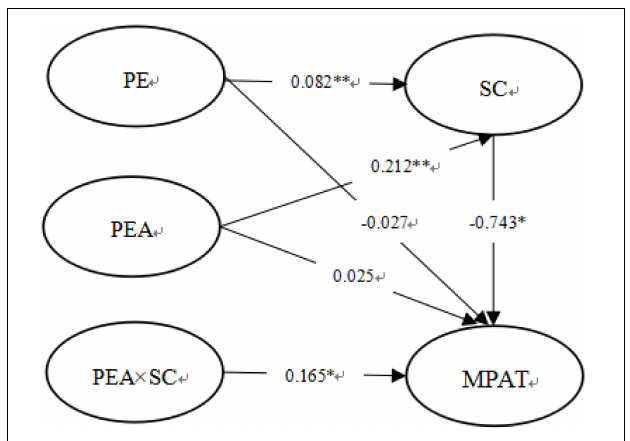
FIGURE 2 | Moderated mediation model.